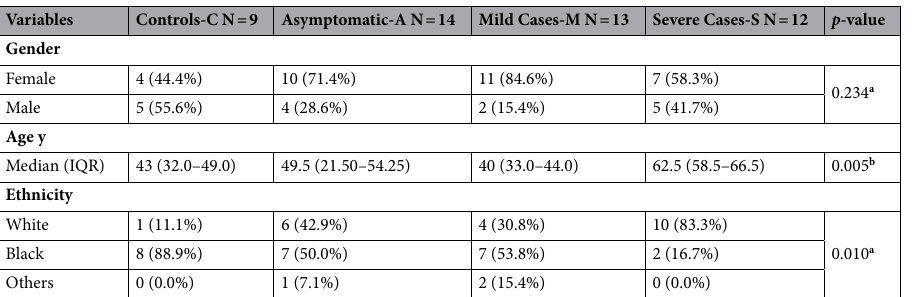
Table 1. Sociodemographic characteristics according to clinical outcome in individuals with SARS-CoV-2 infection and negative controls (n = 48). y years: IQR Interquartile Range: Mild Cases-M : Non-hospitalized; Severe cases-S : Hospitalized. a Fisher’s exact test. b Kruskal–Wallis